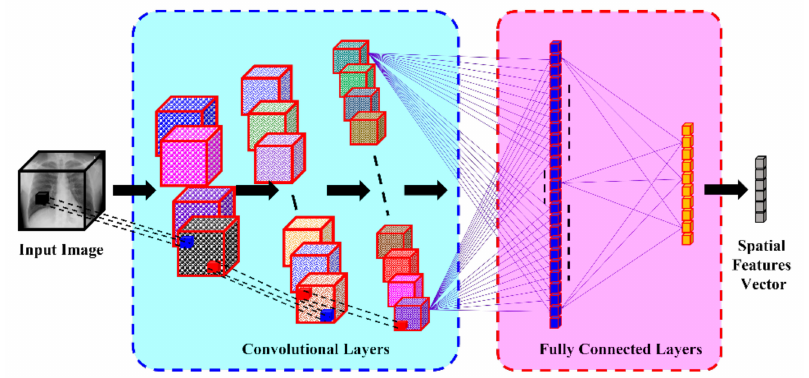
Figure 6. Spatial features extraction.